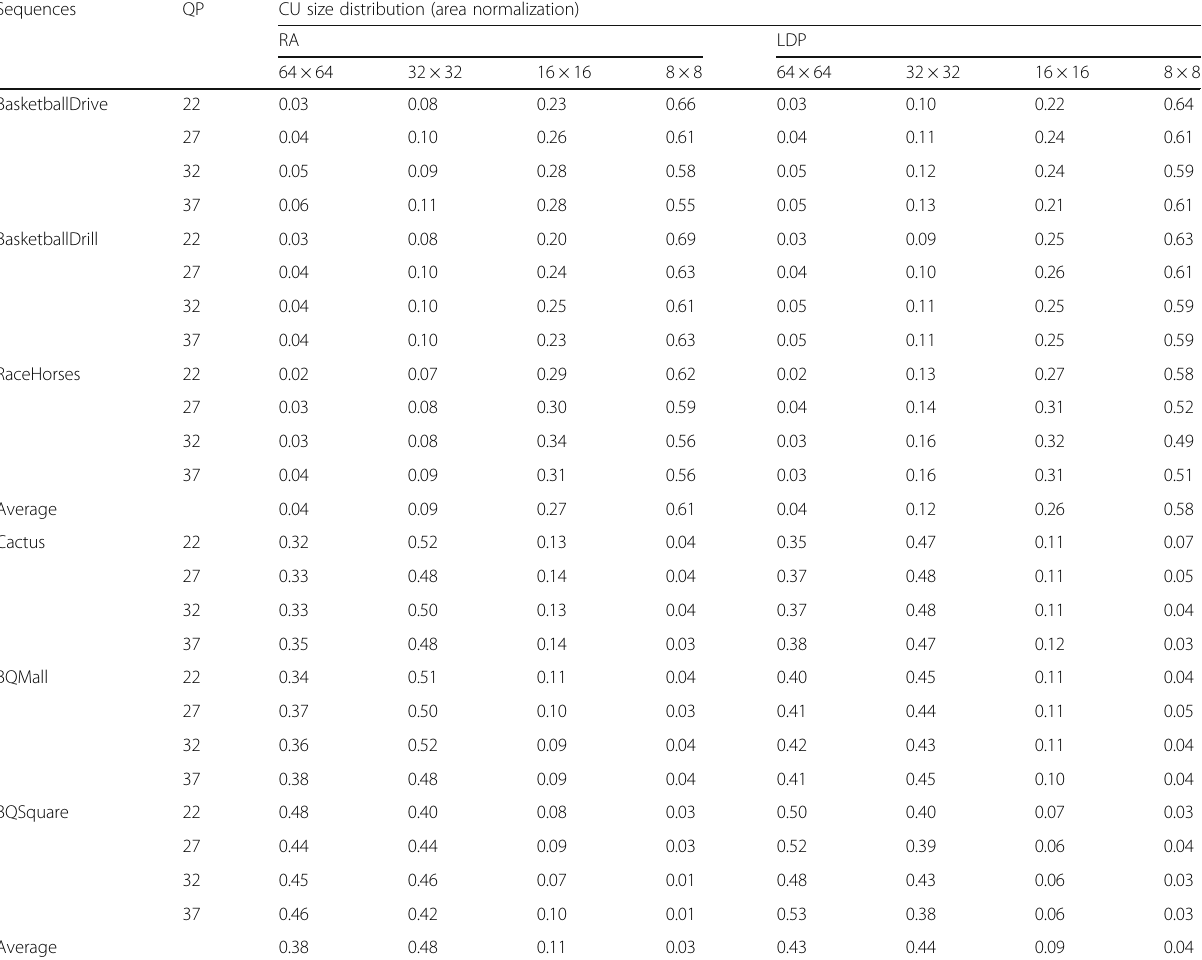
Table 4 Distribution of CU sizes for six typical test sequences